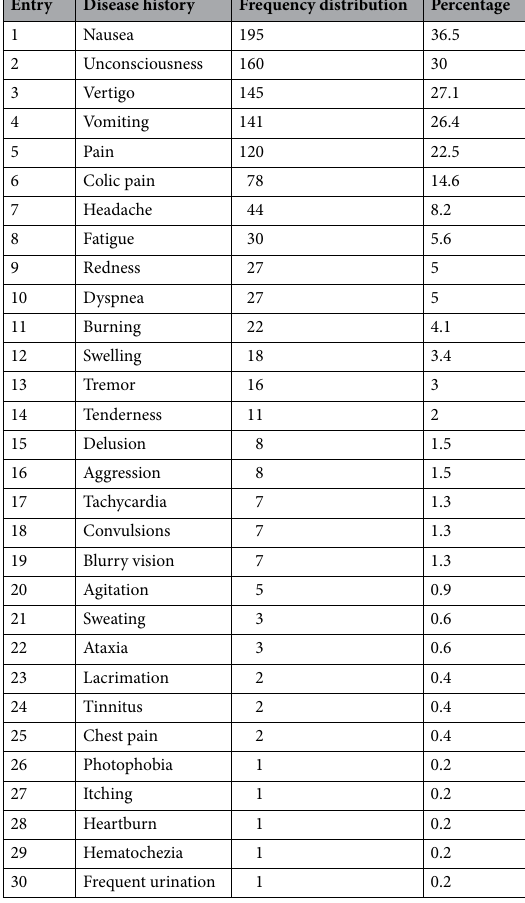
Table 5. Signs/symptoms in studied poisoned patients; frequency distribution in 534